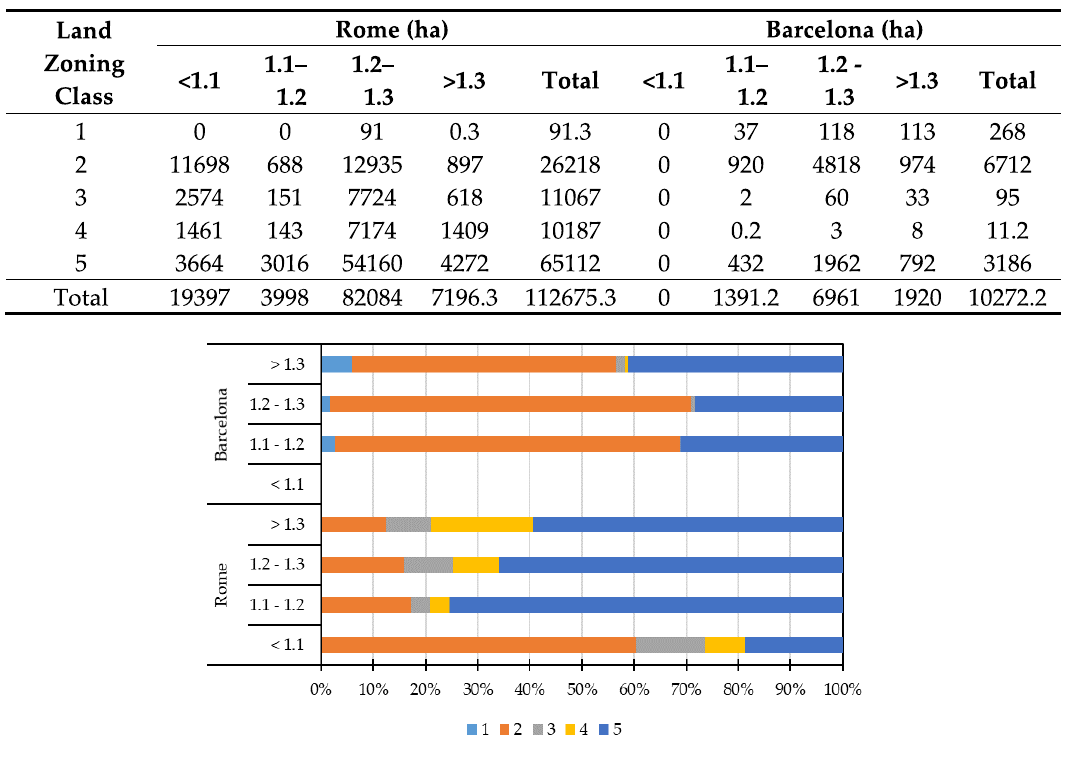
Figure 4. Sensitivity to desertification index (SDI) values represented by zoning classes 1–5 (see Table 1) in hectares (upper table) and percentages (bar plot) in Rome and Barcelona.